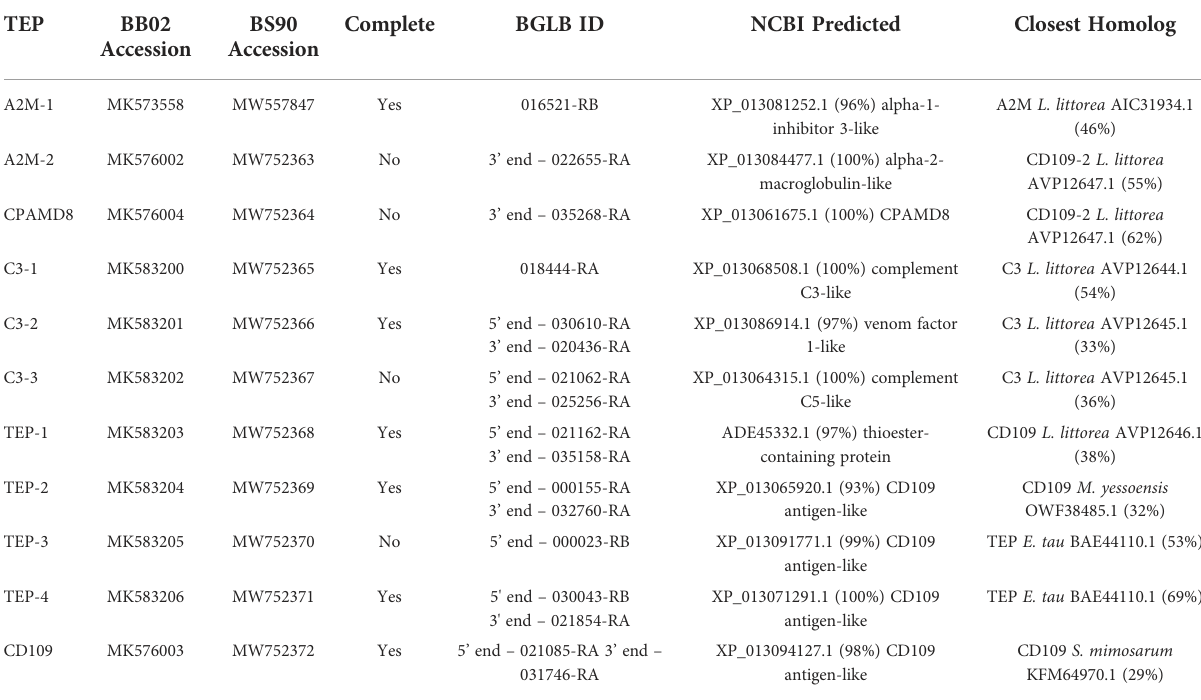
TABLE 1 B. glabrata BB02 and BS90 sequence identi fi